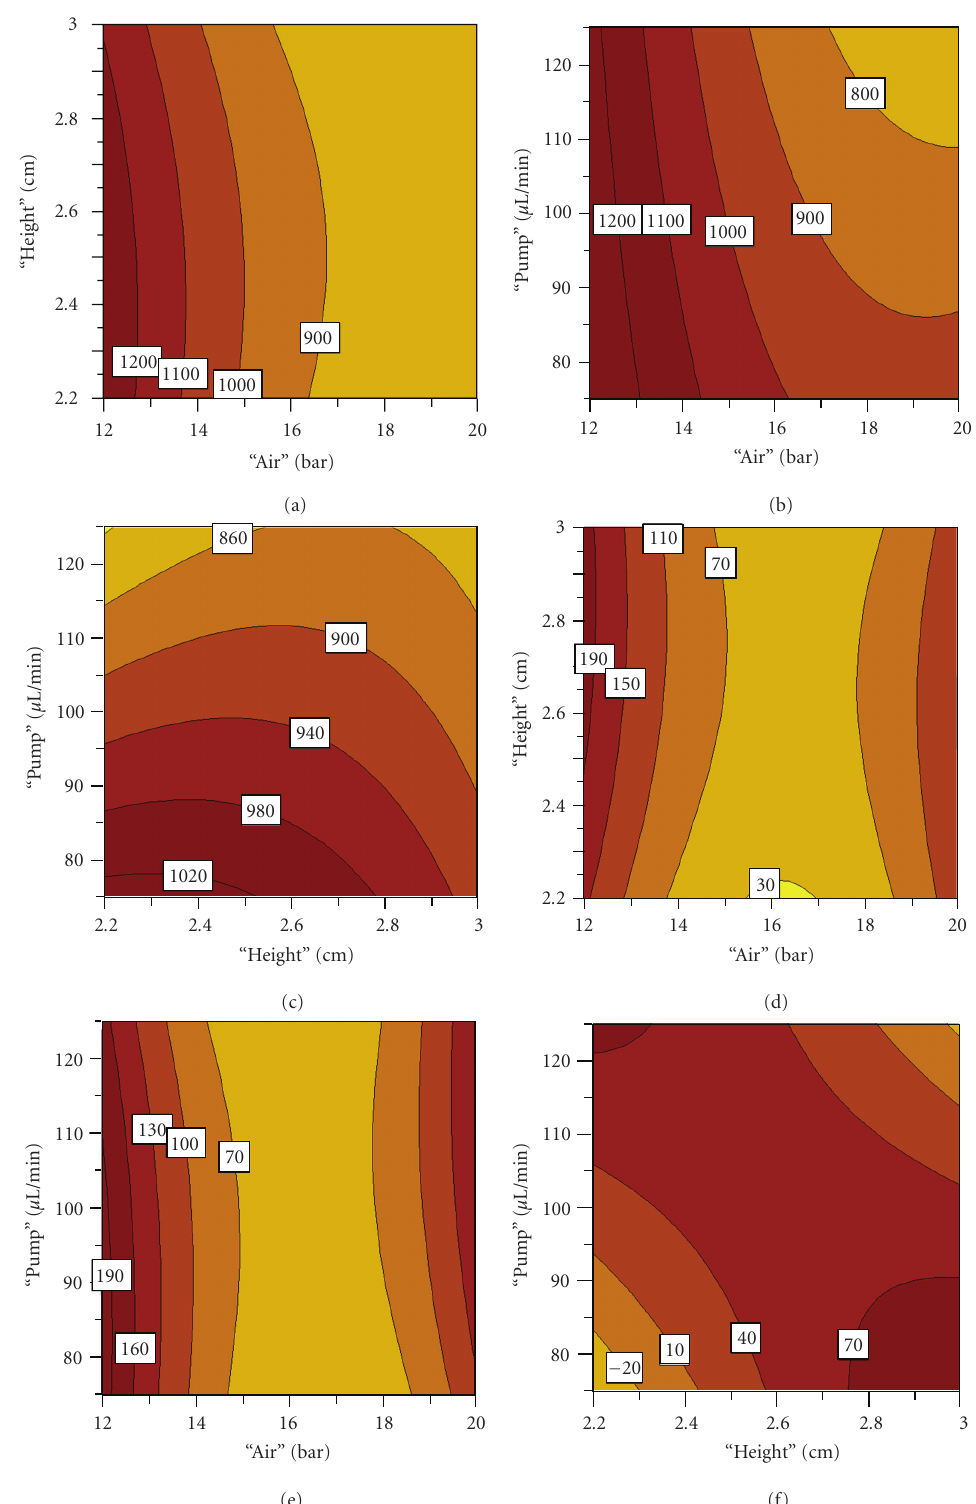
Figure 4: DoE analysis for the production of alginate microbeads containing IB3-1 cells. Contour plots of the responses: “size” (a)–(c) and “SD” (d)–(f). The following interactions were reported: “height versus air” (a,d); “pump versus air” (b,e); and “pump versus height”